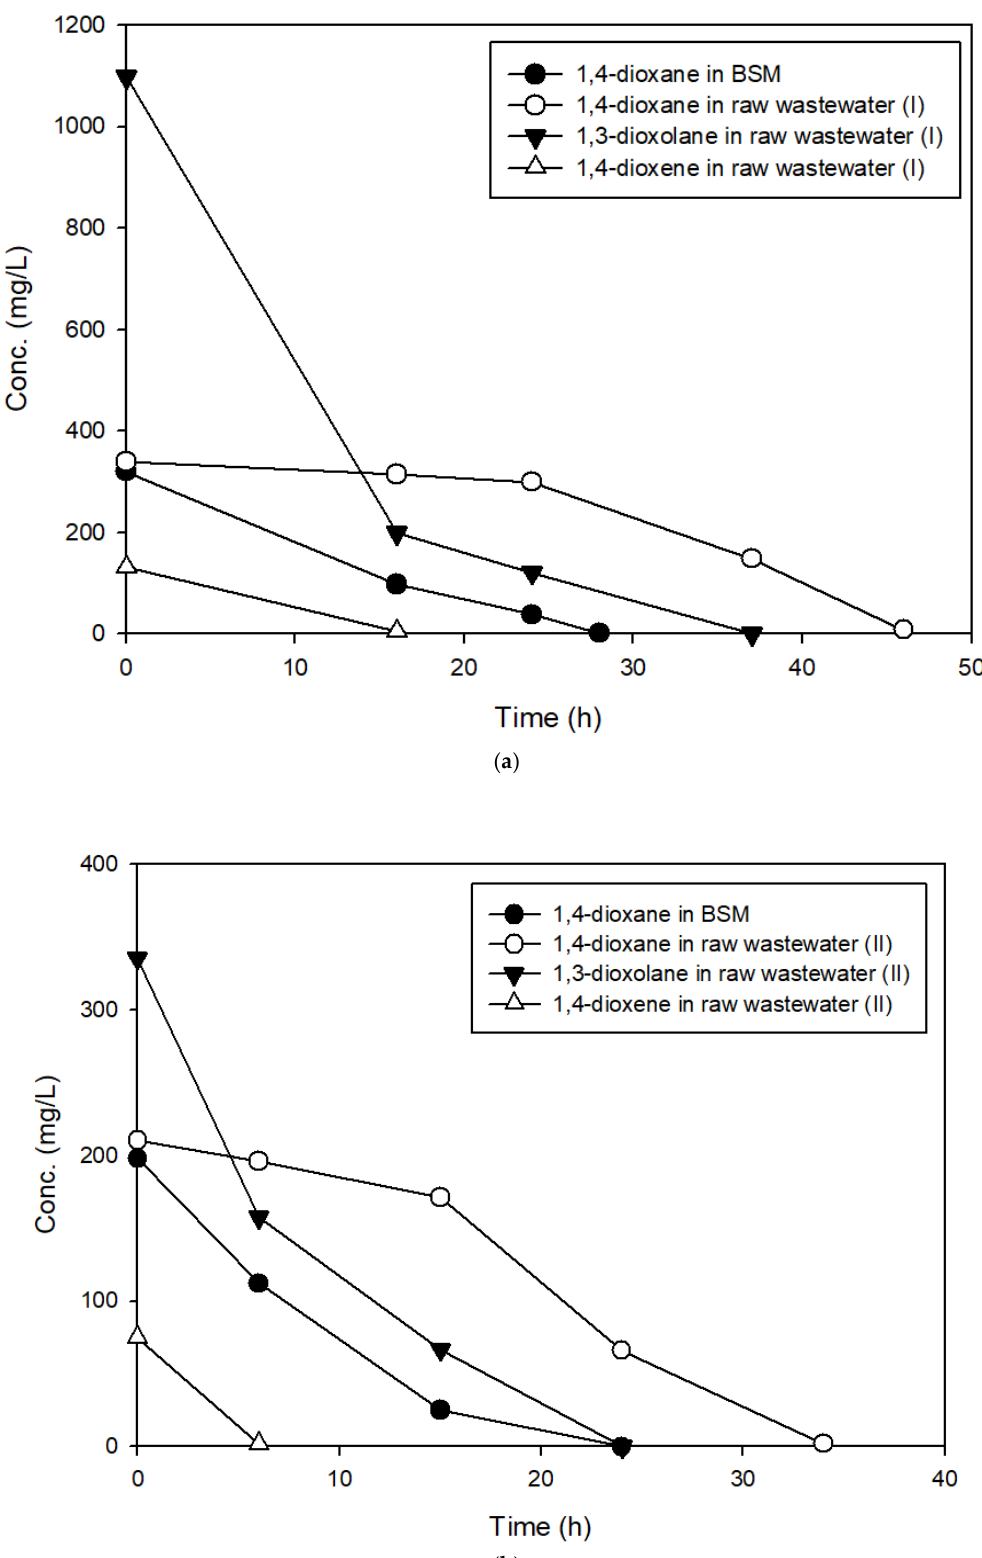
Figure 13. Biodegradation of 1,4-dioxane in the raw textile wastewater: ( a ) wastewater I, ( b ) wastewater II. BSM: basic salt media.